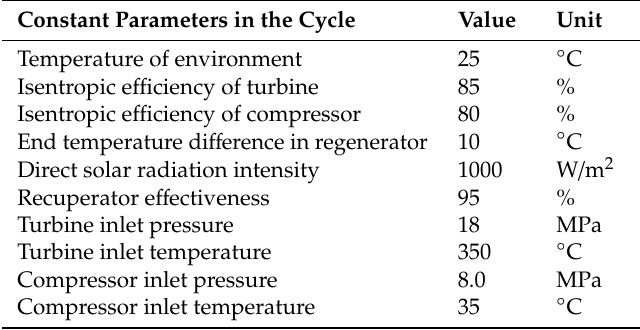
Table 4. Base condition for the parameter study.